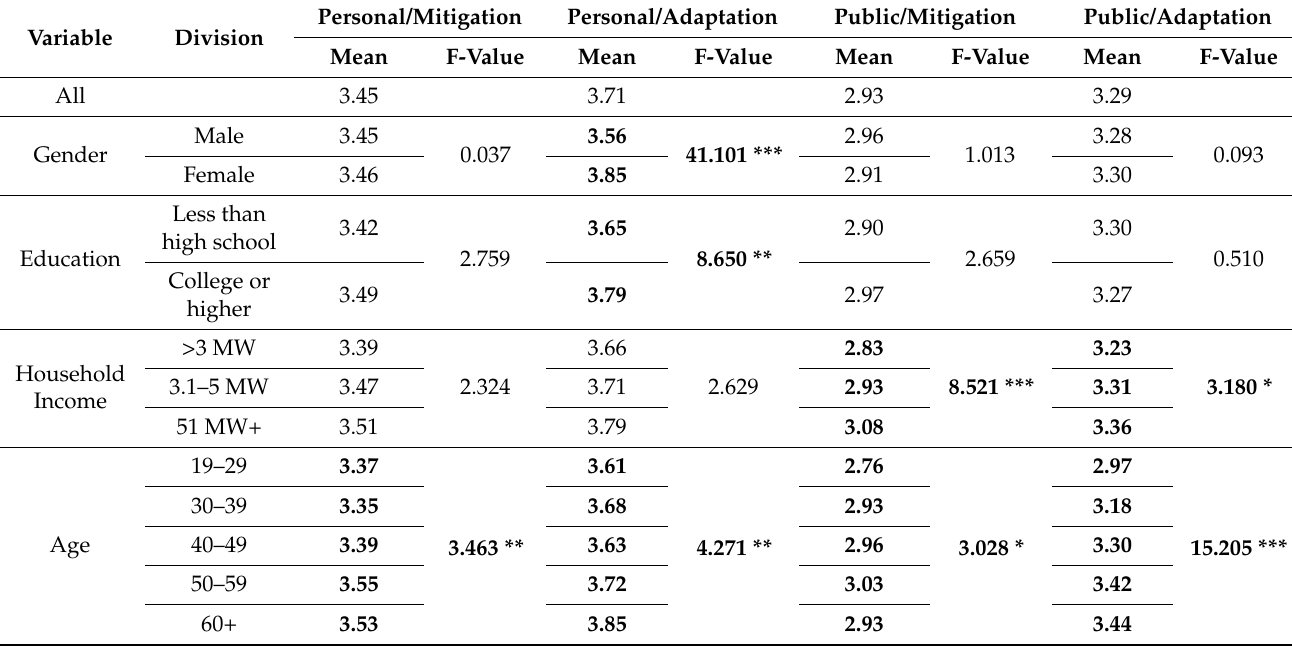
Table 4. Comparison analysis of the differences in mean response actions against